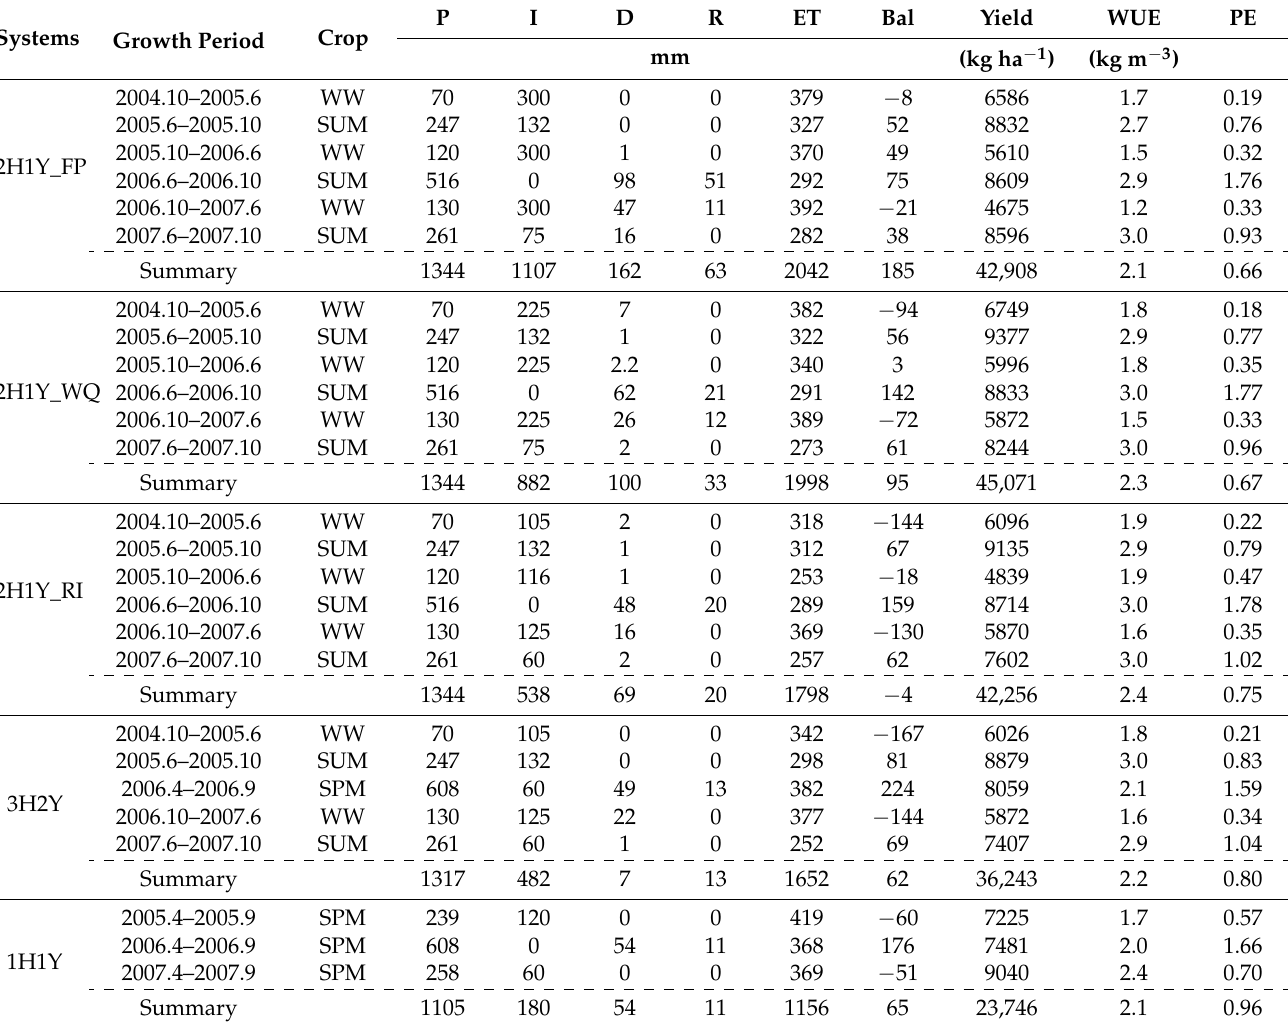
Table 5. Water fluxes of the 120 cm soil profile simulated by the WHCNS model for five